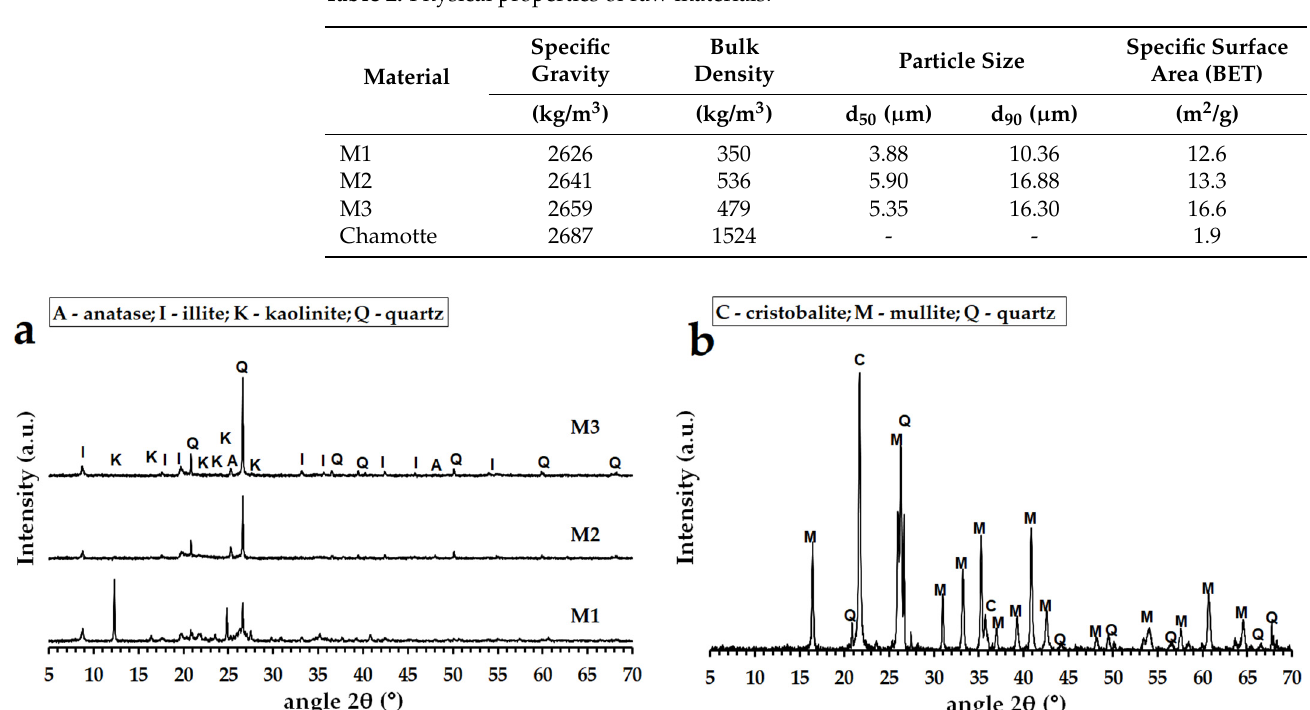
Table 2. Physical properties of raw materials.